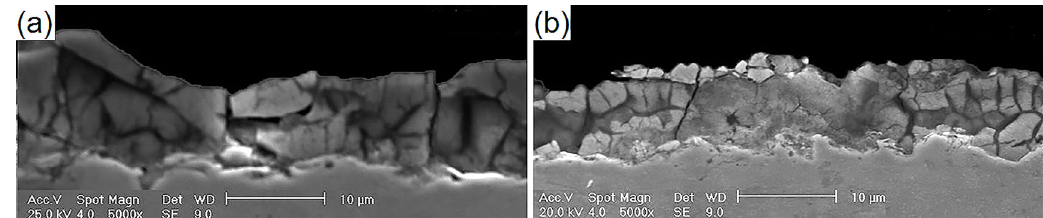
Fig. 6 Effect of post-plating heat treatment on Zn ‒ Ni coatings plated at current density of (a) 30 mA/cm 2 and (b) 48 mA/cm 2 . Reproduced with permission from Ref. [64], © Elsevier,